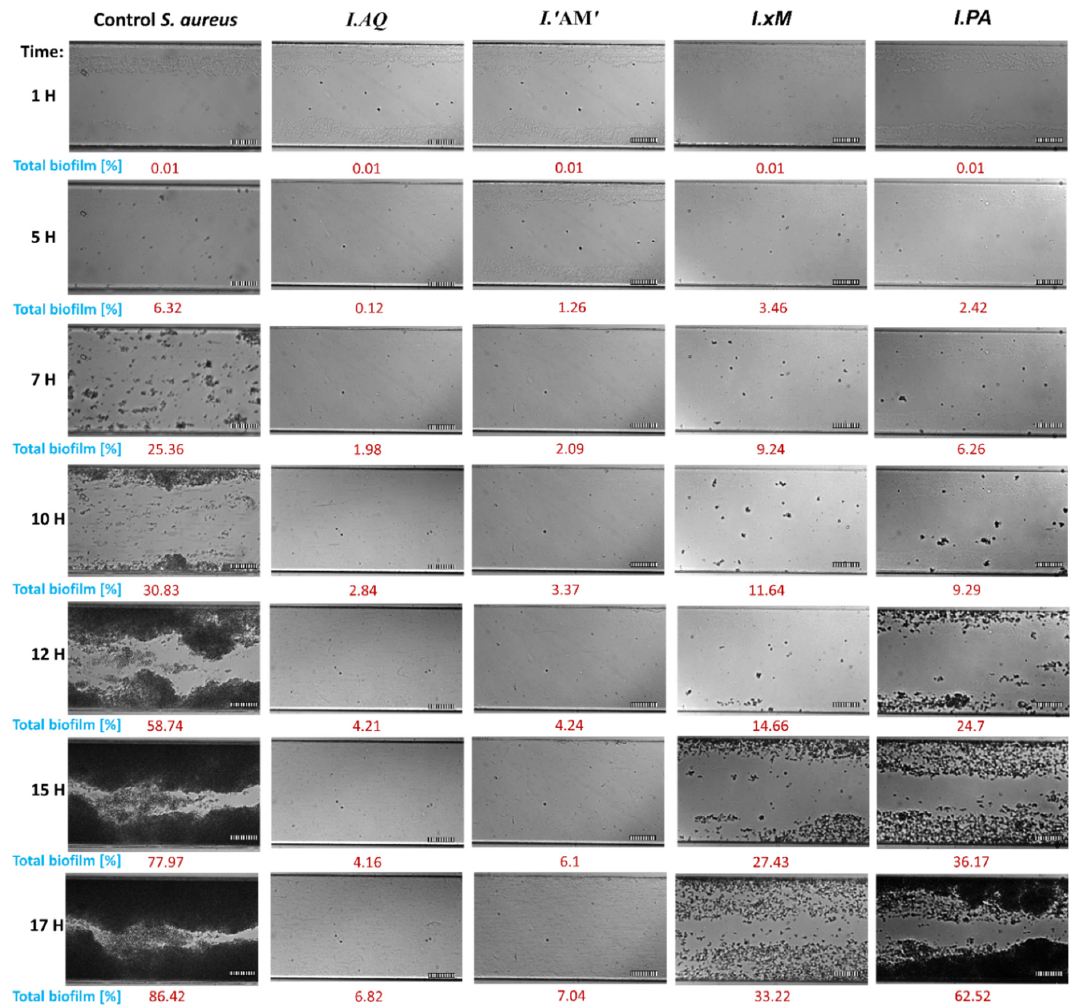
Figure 3. Imaging of the channel cross section with of S . aureus biofilms after 17 h of incubation at flow conditions (0.5 dyn cm 2 ). Biofilms were formed by bacteria treated with water Ilex spp. extracts (1/2 MIC). Biofilms visualized using differential interference contrast (DIC); Control—untreated bacteria; scale bar = 100 µm. Legend: I.PA — I. paraguariensis ; I.AQ — I. aquifolium ; I.’AM’ — I. aquifolium ‘Argentea Marginata’; I. × M — I. × meserveae ‘Blue Angel’.